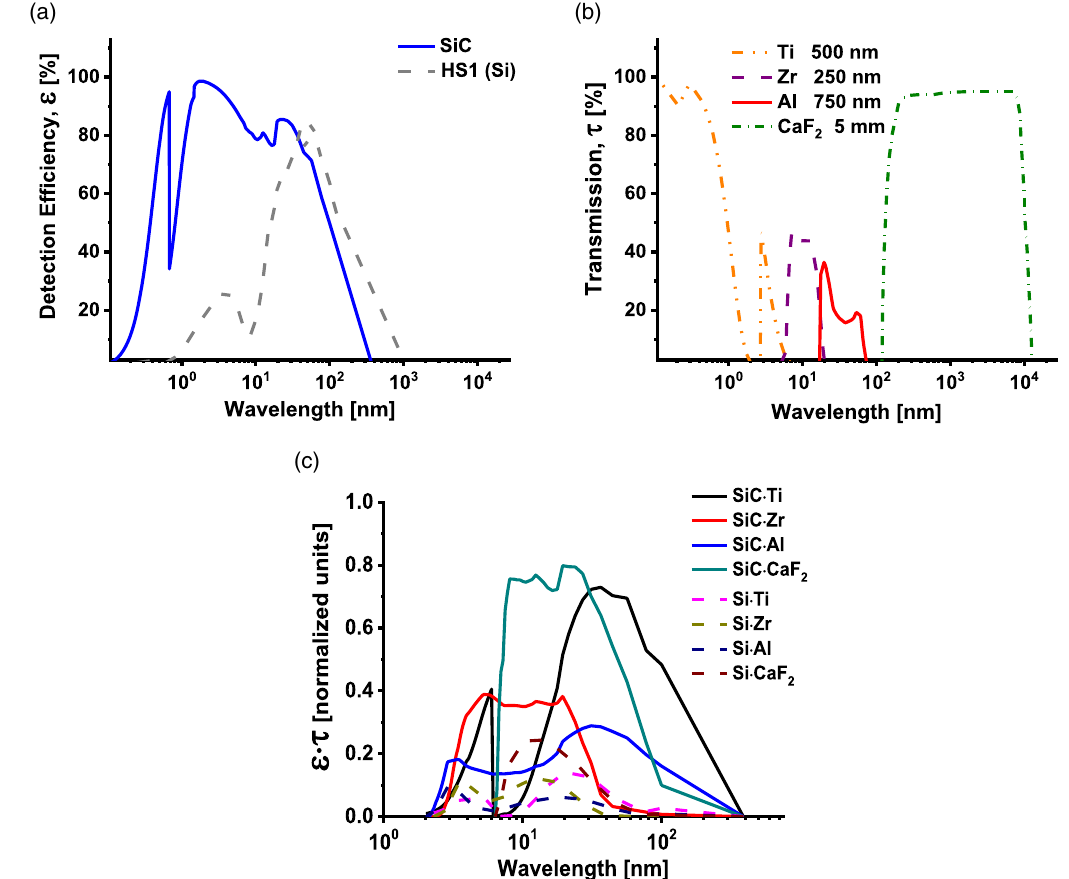
FIG. 2. (a) Detection efficiency ( ε ) of AXUV-HS1 Si and SiC detectors. The SiC detection efficiency spans a range of λ ¼ 0 . 1 – 350 nm, while the Si detector cover the range of λ ¼ 0 . 8 – 950 nm. (b) Transmission ( τ ) of the filters employed at different wavelengths. Finally, (c) reports the contributions of each filter, for both detectors. Each filter allows one to select radiation from different wavelength ranges to modulate the plasma radiation in different wavelength